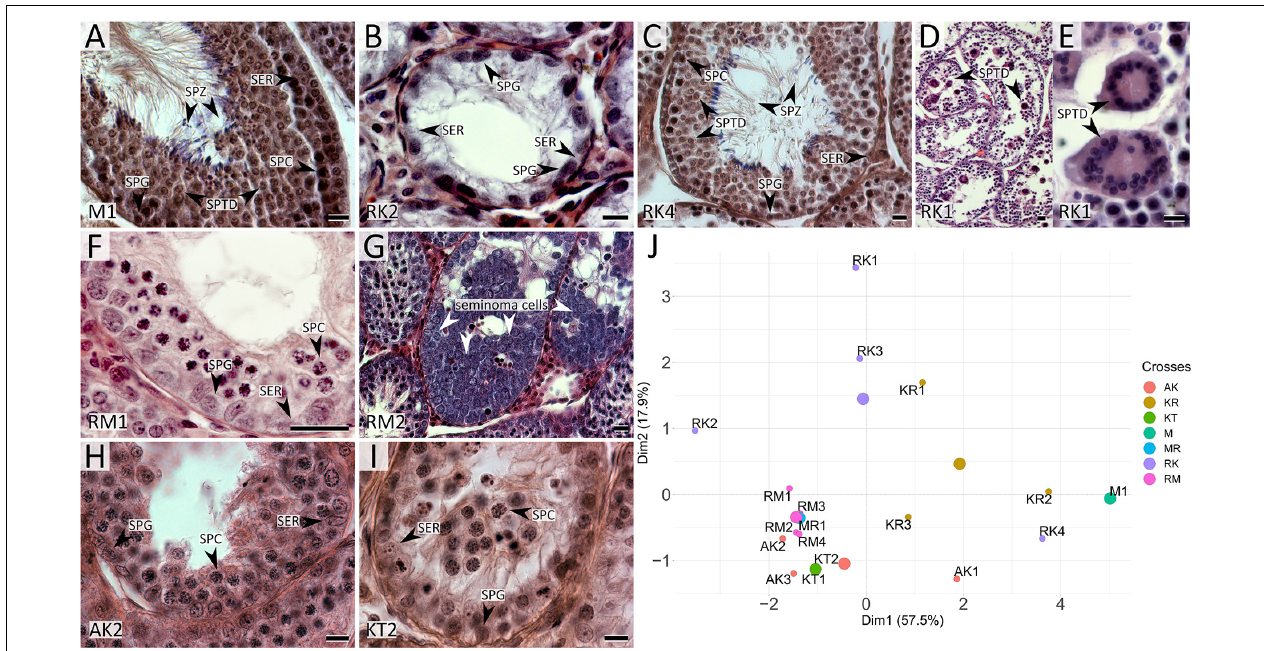
FIGURE 2 | Histological sections of testes of M . mystacinus (A) and M. rossiaemeridionalis × M. kermanensis (B–E) , M. rossiaemeridionalis × M. mystacinus (F,G) , M. arvalis × M. kermanensis (H) and M. kermanensis × M. transcaspicus (I) hybrids stained by hematoxylin–eosin and PCA analysis of histological traits of F1 vole hybrids (J) . SER, Sertoli cell; SPG, spermatogonium; SPC, spermatocyte; SPTD, spermatid; SPZ, spermatozoon. Letters and numbers in the bottom-left corners of the graphs represent the type of cross and individual specimen number. Bar: 10 µ m. In image J: small dots represent specimens, large dots represent centers of the clusters of one cross.